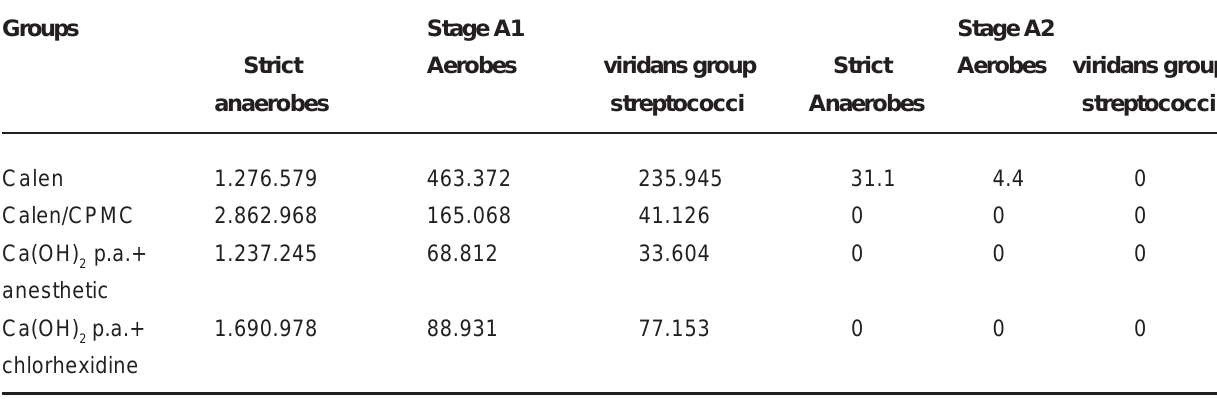
TABLE 2- Percentage of microbial reduction (cfus) for A2 sampling